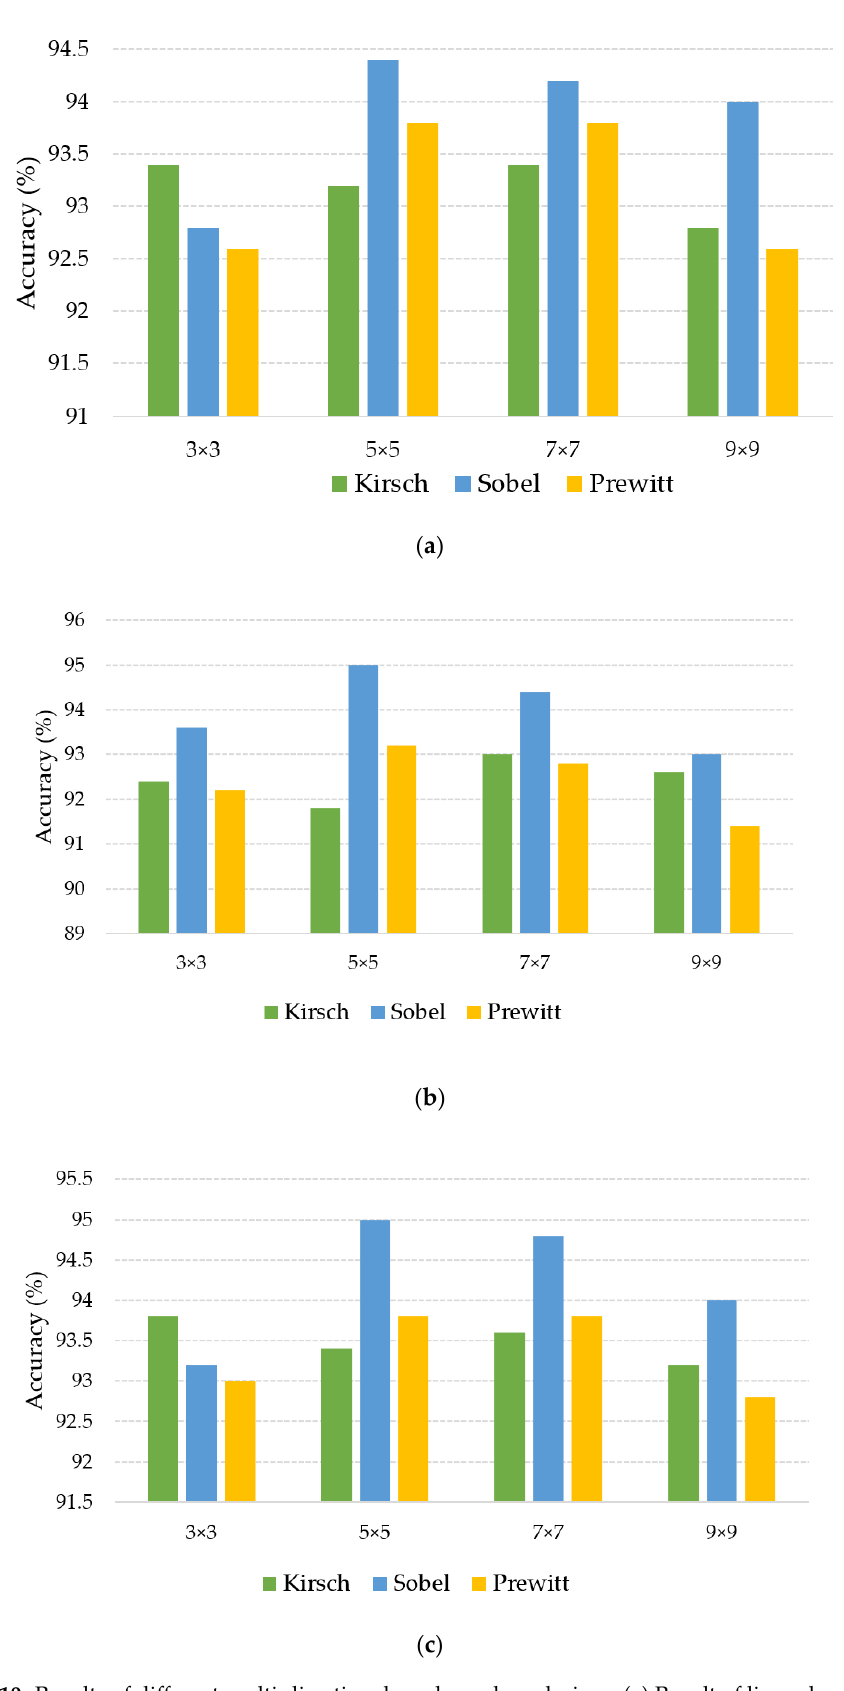
Figure 10. Results of di ff erent multi-directional masks and mask sizes. ( a ) Result of linear kernel SVM; ( b ) result of polynomial kernel SVM; ( c ) result of RBF kernel